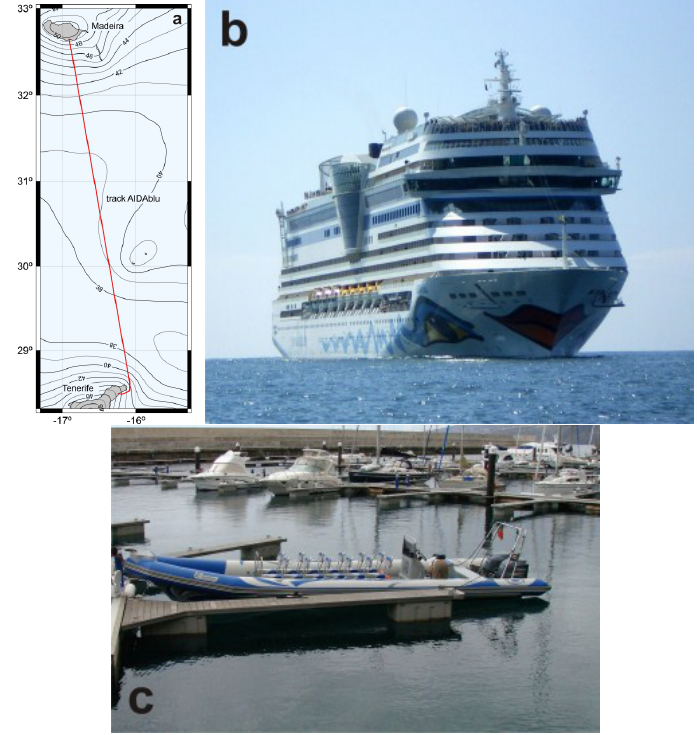
Figure 4. Measured track between Tenerife and Madeira in the Atlantic Ocean, contour lines of EIGEN-6C geoid (a), cruise vessel AIDAblu used in this study (b), escort craft Oceanodroma used for calibration of cruise vessel’s squat